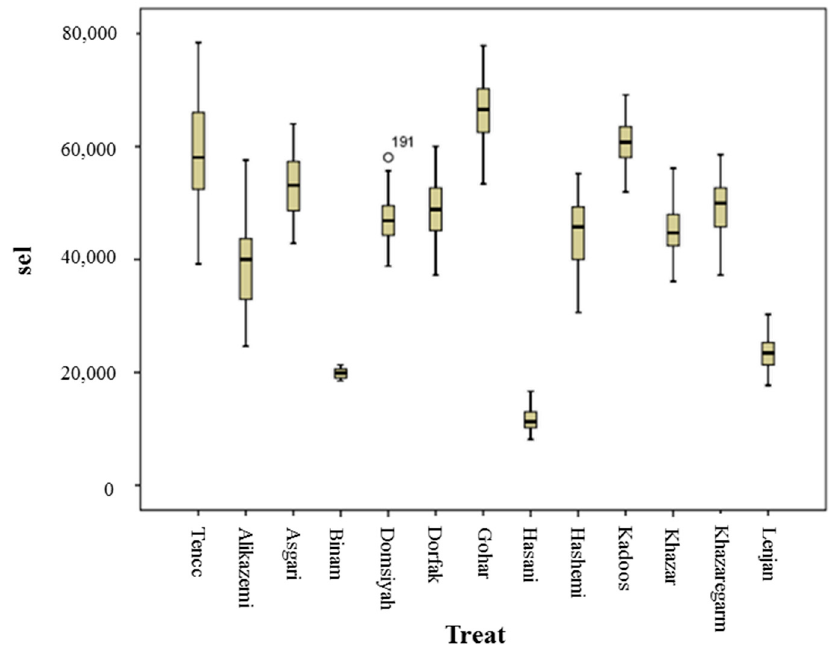
Figure 4. The box plot for 13 brown rice cultivars.